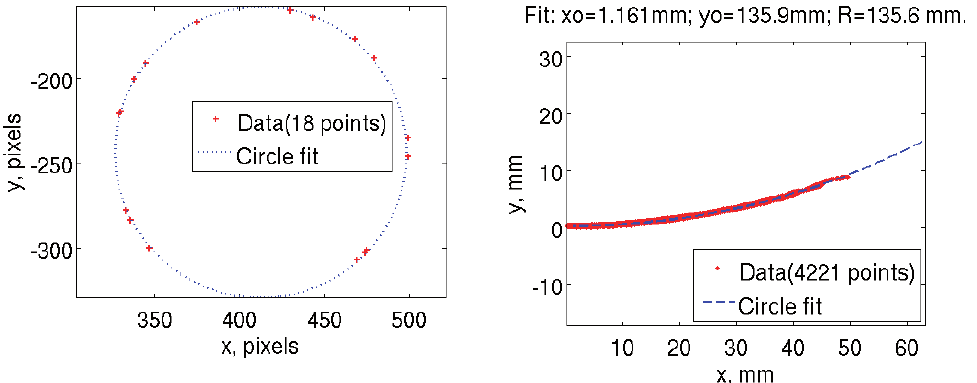
Fig. 2. Circle-fit of ball perimeter. Fig. 3. Circle-fit of ball trajectory.